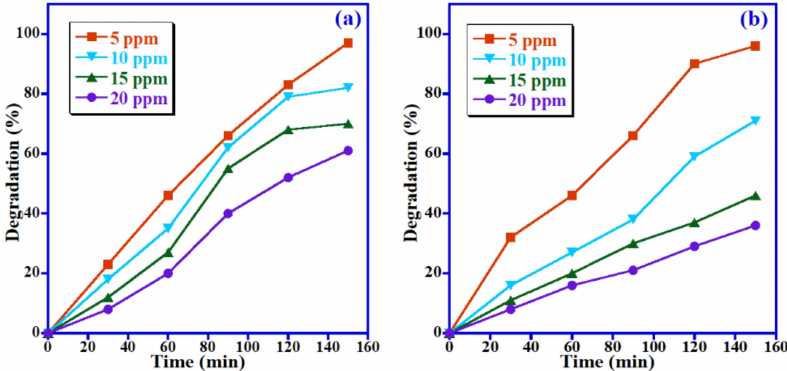
Figure 9. Influence of initial concentration on decomposition of ( a ) MB and ( b )